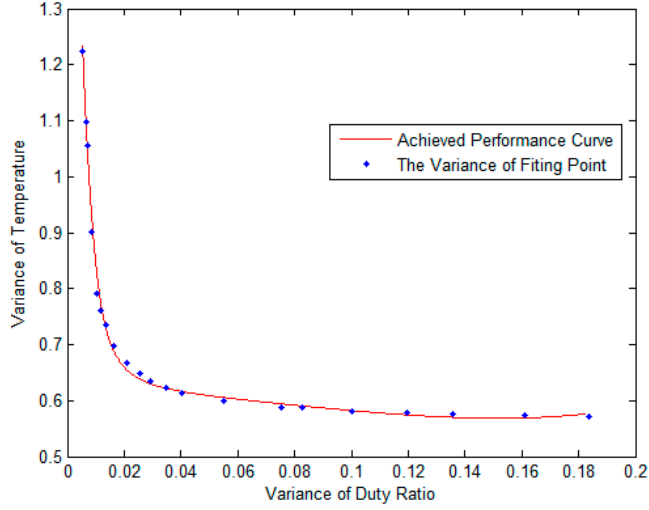
Figure 5. The LQG performance tradeoff curve.